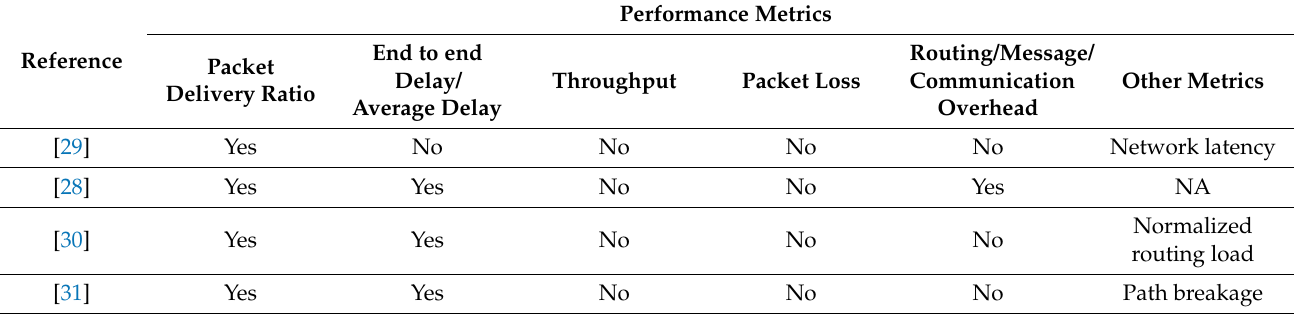
Table 7. Performance metrics of hybrid scenario-based routing